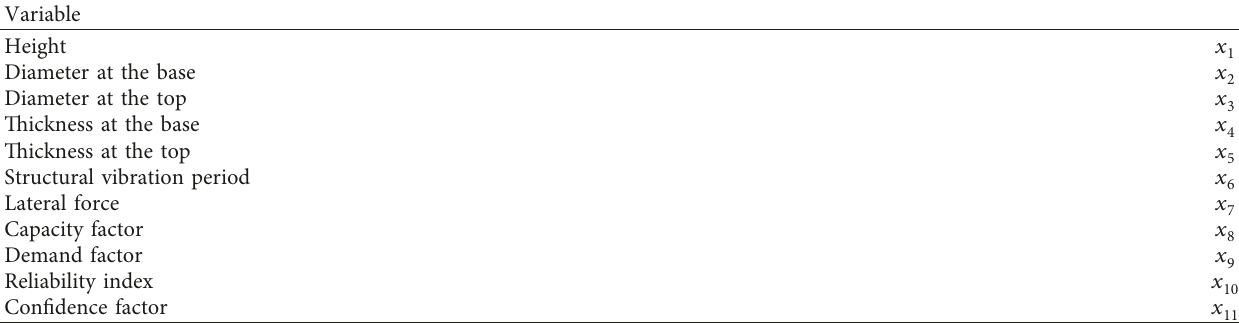
Figure 7: Demand factor vs height and structural vibration period, corresponding to β � 3.4. Table 1: Input variables used for response surfaces and